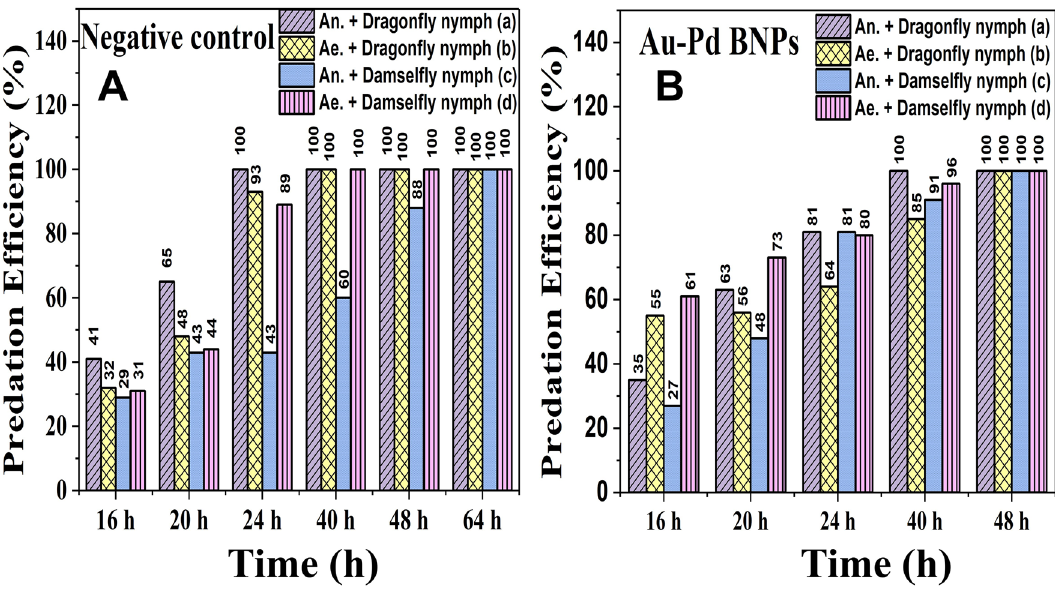
Figure 11. ( A ) Negative Control and ( B ) Au–Pd BNPs Concentration to test the predation efficiency of the (a) Dragonfly nymphs with III instar larvae of Anopheles stephensi (An.), (b) Dragonfly nymphs with III instar larvae of Aedes aegypti (Ae.), (c) Damselfly nymphs with III instar larvae of Anopheles stephensi , and (d) Damselfly nymphs with III instar larvae of Aedes aegypti